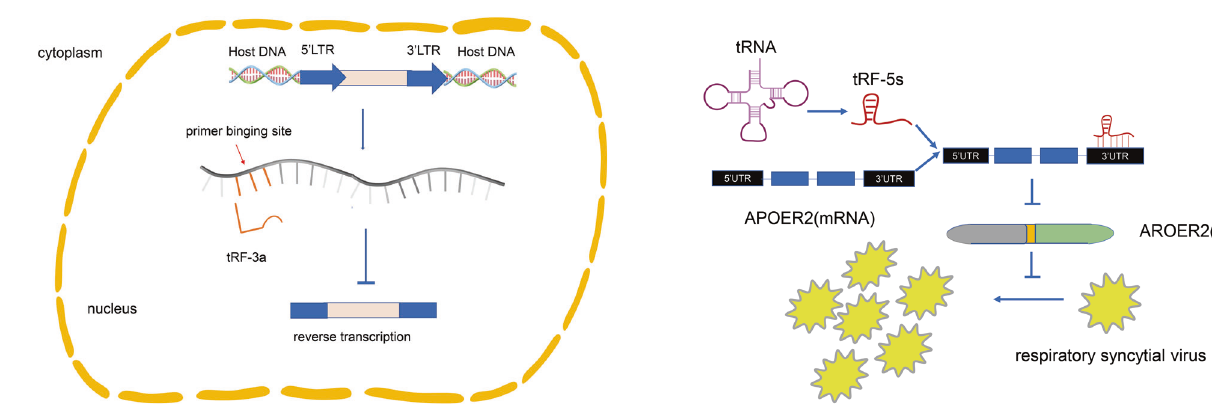
Fig. 5 The function of tsRNA on participation in epigenetic regulation. tRF-3a inhibits long terminal repeat (LTR)-retrotranspo- son or endogenous retrovirus (ERV) activity by targeting the highly conserved primer binding site of LTR-retrotransposon.